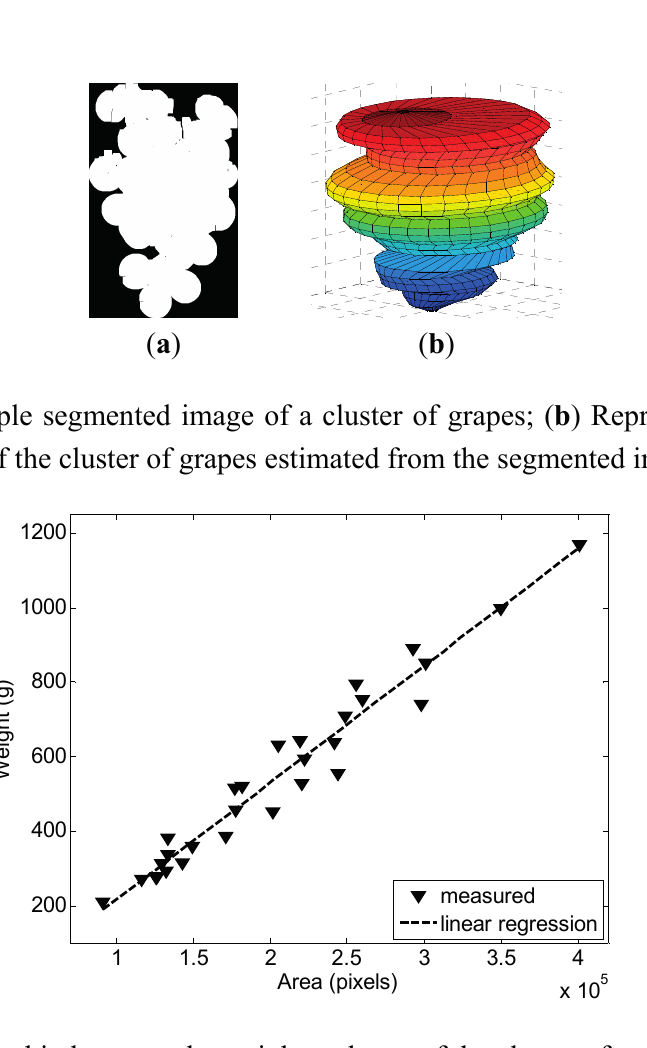
Figure 3. Relationship between the weight and area of the cluster of grapes analyzed.